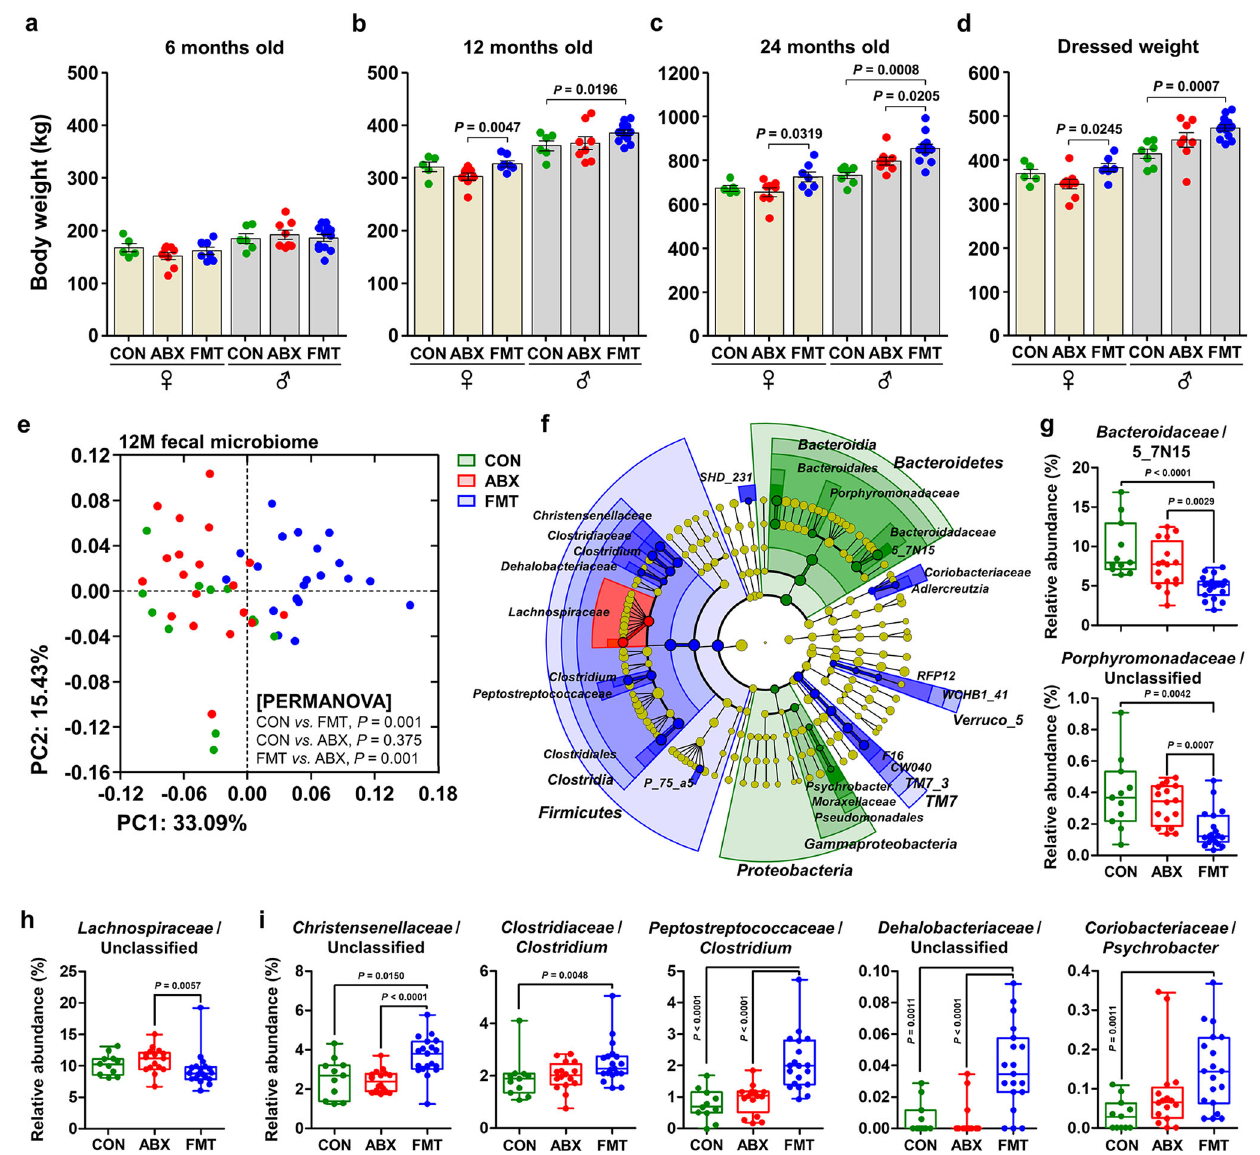
Fig. 5 The effect of FMT-driven gut microbial assembly on growth performance. a – c Body mass of the cattle ( n = 50) at 6 ( a ), 12 ( b ), and 24 ( c ) months of age. d Dressed mass of the cattle at 24 months of age ( n = 50). Bar graphs and dot plots are colored according to sex and treatment. e Metataxonomic pro fi les of the gut microbiome in the 12-month-old cattle ( n = 50). PCoA of the rectal bacterial 16S rRNA gene sequences, based on the weighted UniFrac distance matrix. The data were analyzed using PERMANOVA, with 999 permutations. f The enriched microbial taxa in each group of 12-month-old cattle were identi fi ed using LEfSe and are presented using the circular cladogram. The discriminating taxa for each group are denoted in different colors. g – i Relative abundances of the discriminating taxa were compiled in the feature ASV table, based on the SILVA database for the CON ( g , n = 11), ABX ( h , n = 19), and FMT ( i , n = 20) groups, and are presented as box and dot plots. The lines, boxes, and whiskers in the box plots represent the median, and 25th, and 75th percentiles, and the min-to-max distribution of replicate values, respectively. Data are shown as mean ± SEM and were analyzed using